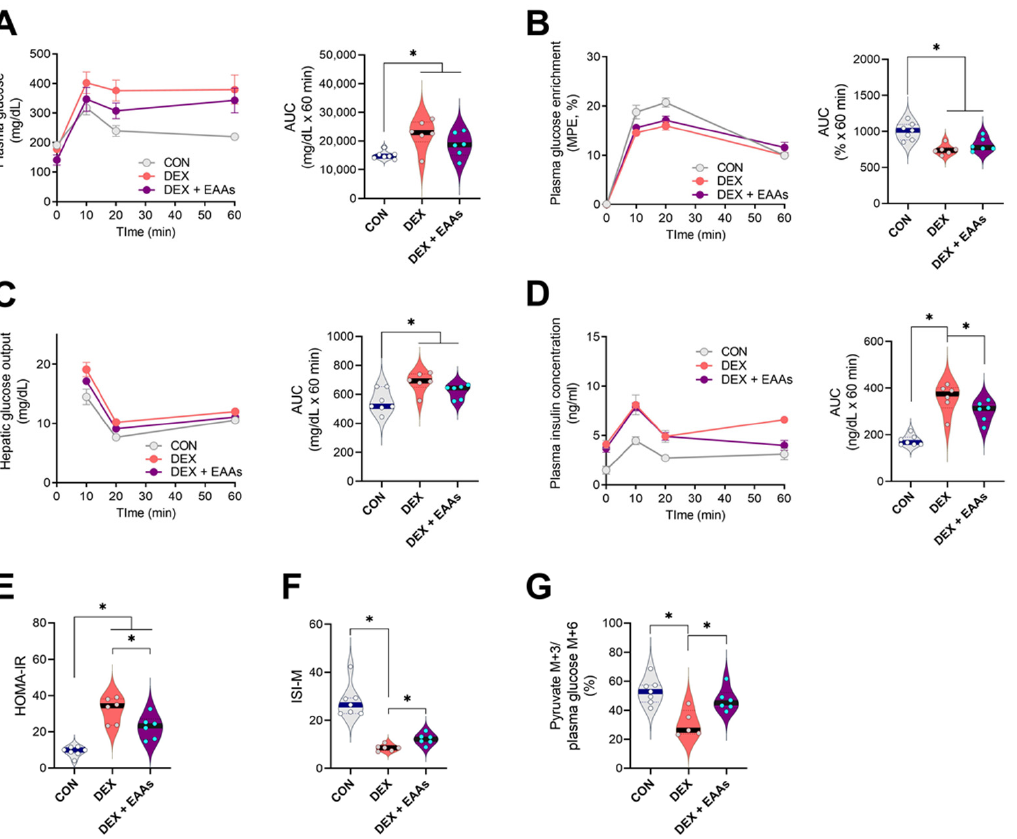
Figure 3. The EAA-enriched diet improved impaired insulin sensitivity and glucose uptake in DEX- induced muscle atrophy. ( A ) Plasma glucose concentration during the oral glucose tolerance test (OGTT) ( n = 6–7). ( B ) Plasma glucose enrichment during the OGTT ( n = 6–7). ( C ) Hepatic glucose output during the OGTT ( n = 6–7). ( D ) Plasma insulin concentrations during the OGTT ( n = 6–7). ( E ) HOMA-IR ( n = 6–7). ( F ) Matsuda insulin sensitivity index ( n = 6–7). ( G ) GA muscle pyruvate M+3 to plasma glucose M+6 ratio ( n = 6–7). Data are presented as mean ± S.E. * Significant difference between labeled groups (* p < 0.05). CON, control; DEX, dexamethasone; EAAs, essential amino acids; GA, gastrocnemius, MPE, mole percent excess; AUC; area under curve; HOMA-IR, homeostatic model assessment of insulin resistance; ISI-M, Matsuda-DeFronzo insulin sensitivity index.